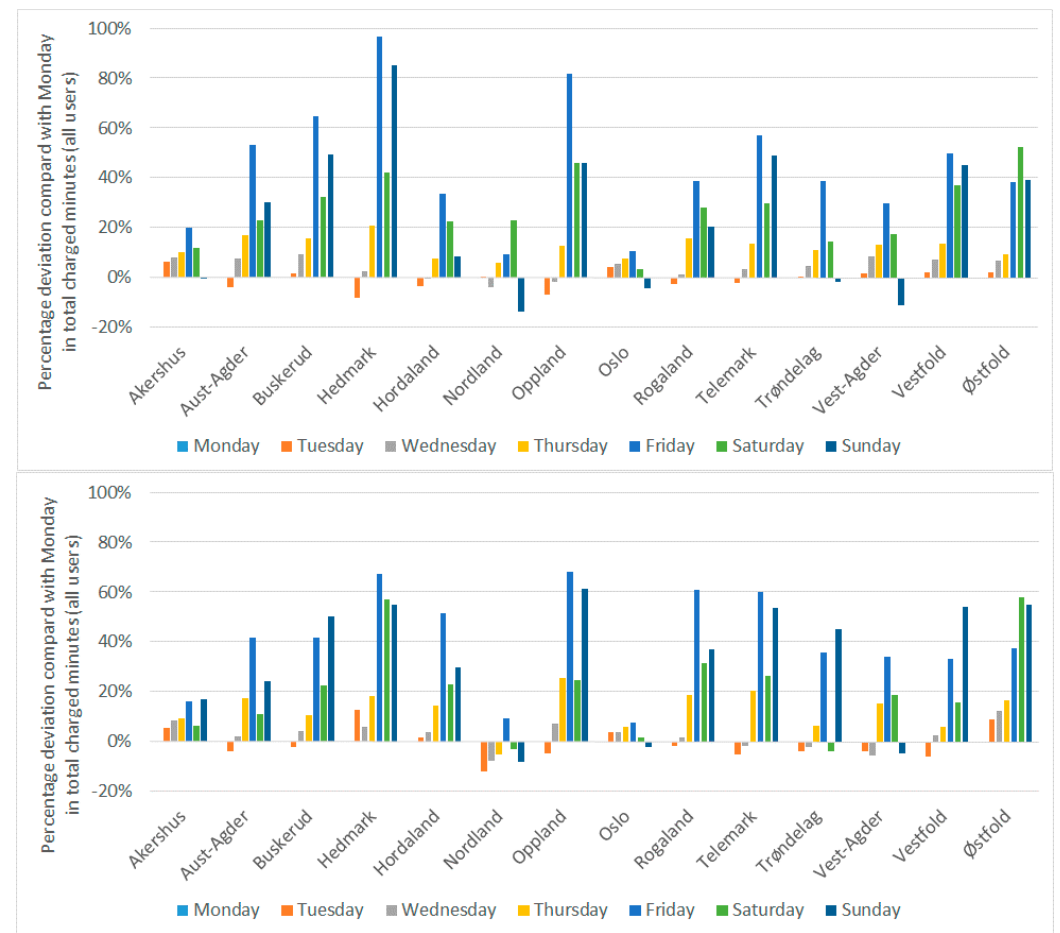
Figure 9. Percentage deviation in total minutes (all users) fast charged in network of operator 1 ( top ) and operator 2 ( bottom ) compared to minutes charged on Mondays (equal 0%) for each County. 2017. Source: Dataset 1, dataset 2 and own analysis.